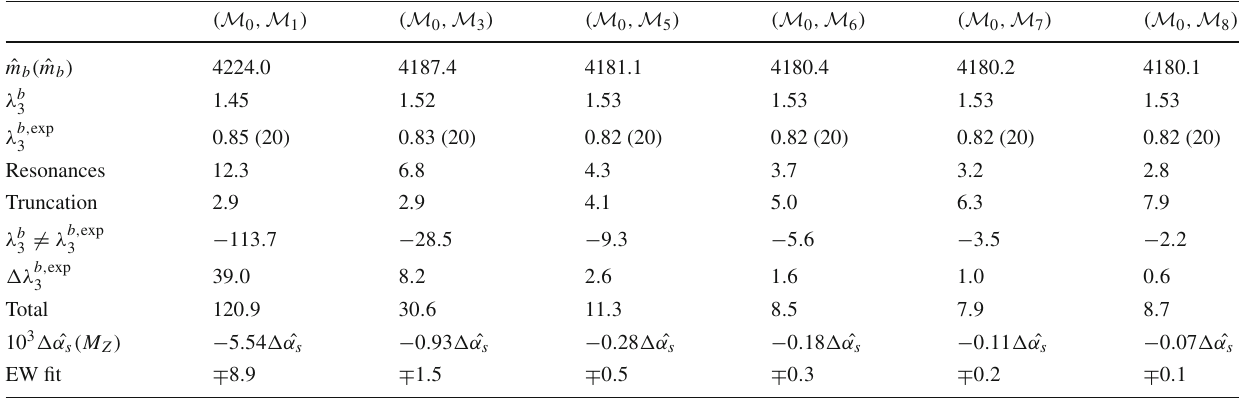
Table 3 Above the double line: values of ˆ m b ( ˆ m b ) (in MeV), λ b λ b , exp , determined from different pairs of moments as described in the 3 text, where the ϒ( 4 S ) and ϒ( 5 S ) resonances have been added explic- itly to the ansatz in Eq (5). Below the double line: breakdown of the uncertainties in ˆ m b ( ˆ m b ) followed by the total errors. The